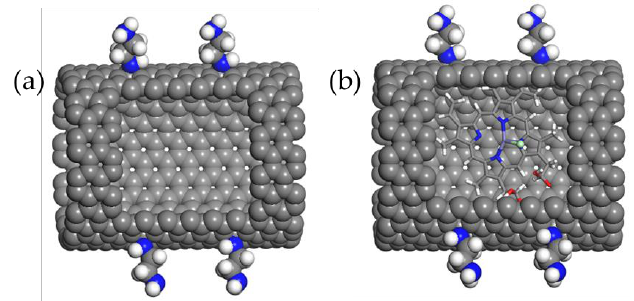
Figure 11. Models of ( a ) amine-functionalized MWCNT, ( b ) the HA-MWCNT membrane active